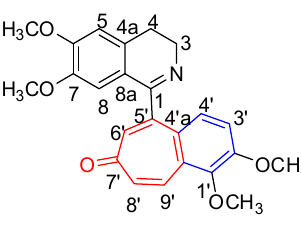
Figure 1. Structure of mahimbrine A.